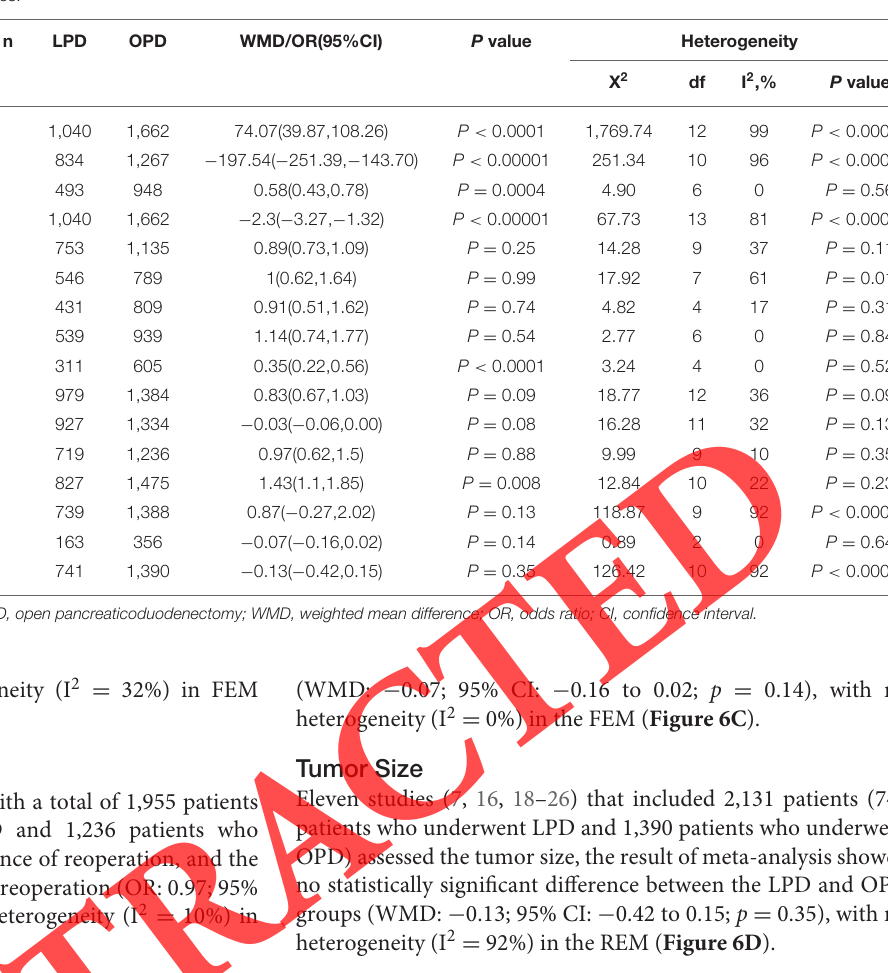
TABLE 2 | Summary results of the